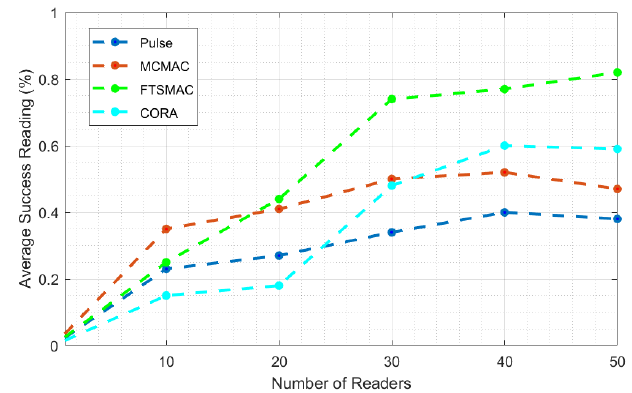
Figure 7. System performance vs. number of readers .